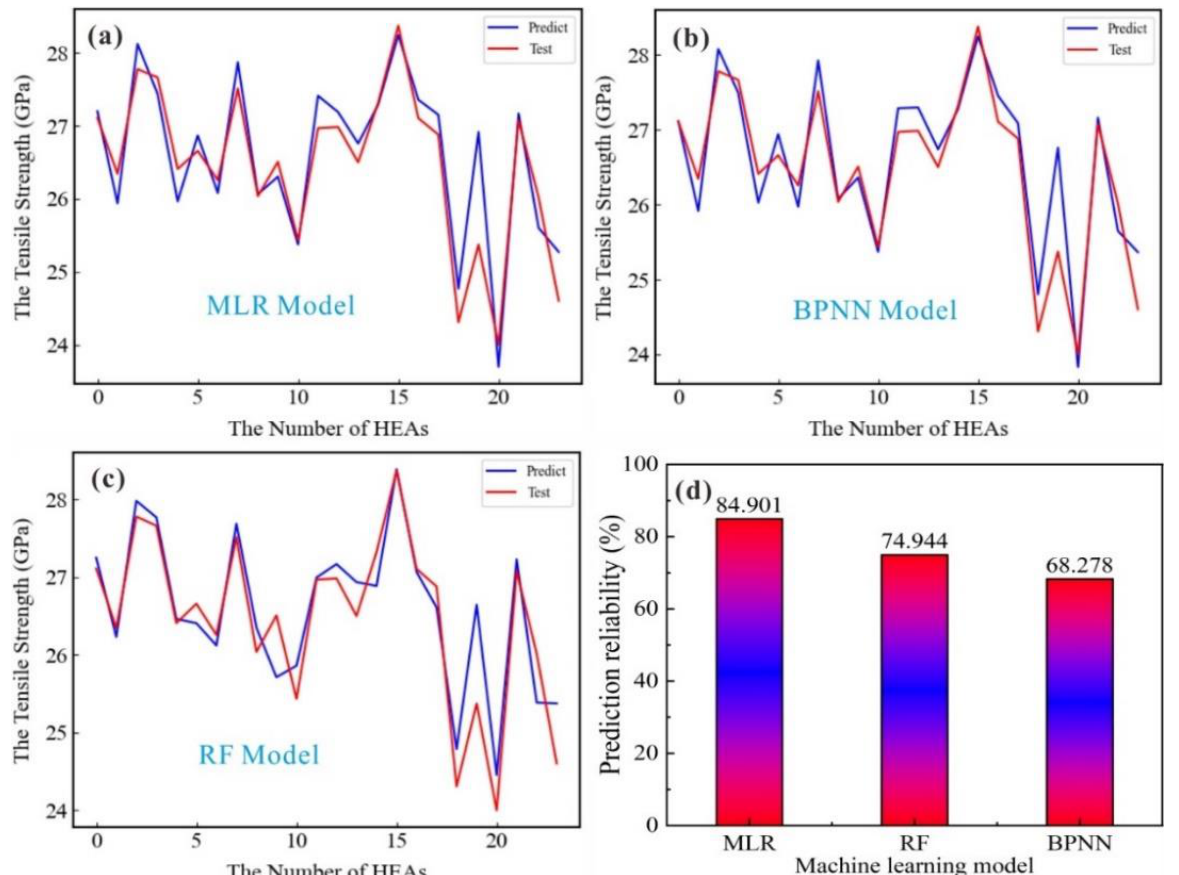
Figure 3. ( a ) MLR model test set prediction control; ( b ) BPNN model test set prediction control; ( c ) RF model test set prediction control; ( d ) Prediction confidence of three ML models.